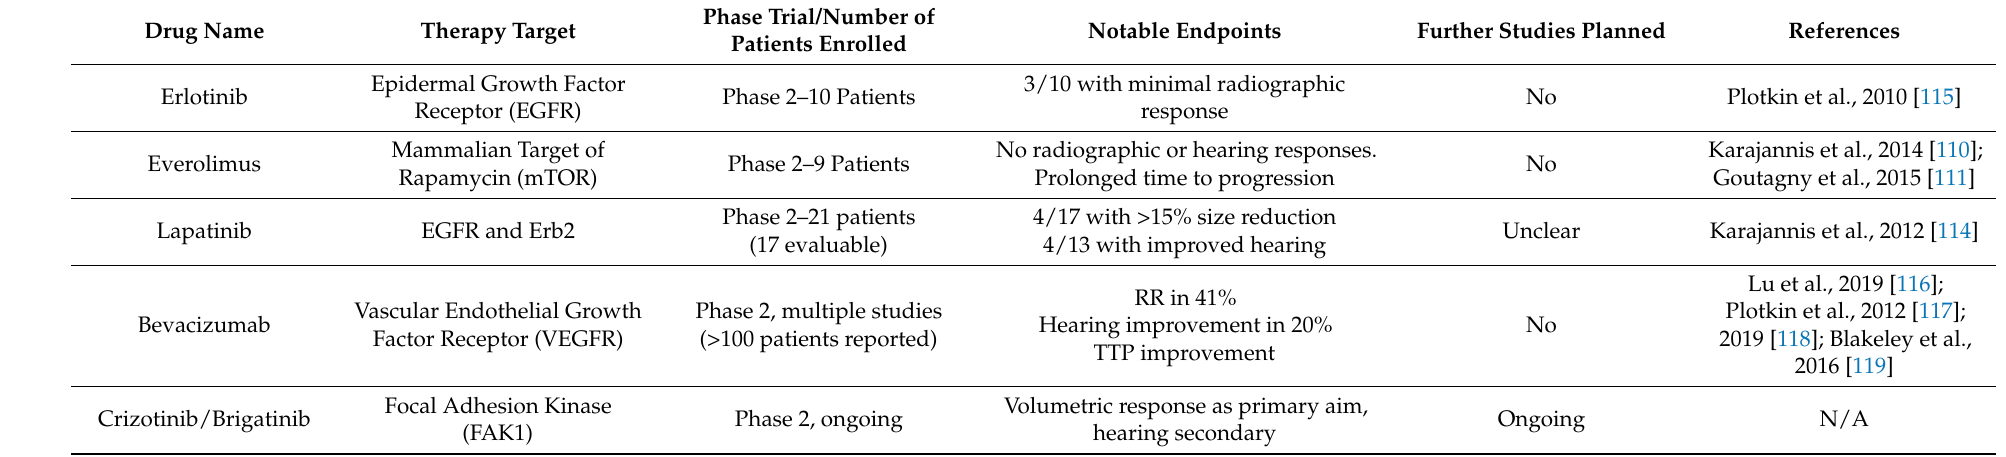
Table 1. Recent clinical trials assessing targeted therapy for NF2-associated vestibular schwannomas with intended targets, phases of therapy, endpoints, and